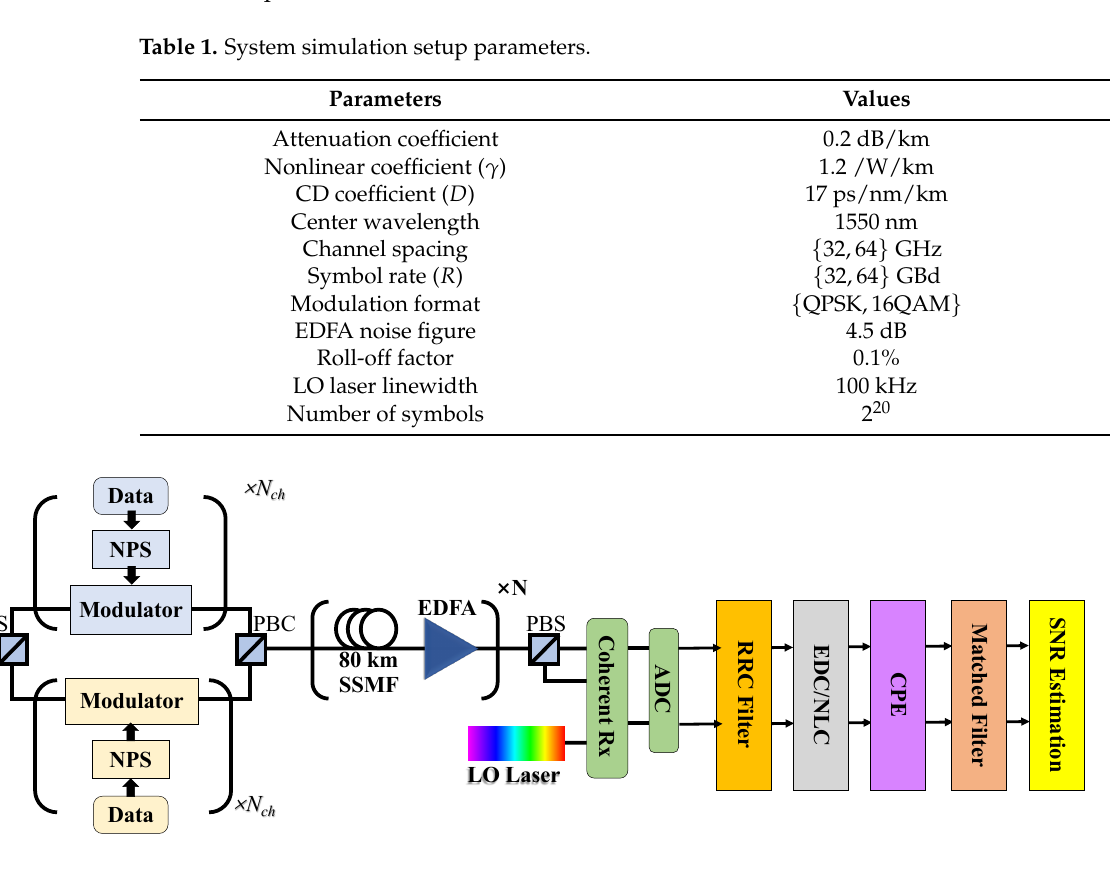
Figure 2. Scheme of the dual-polarization Nyquist-spaced multichannel communication system. PBS: polarization beam-splitter; PBC: polarization beam combiner; NPS: Nyquist